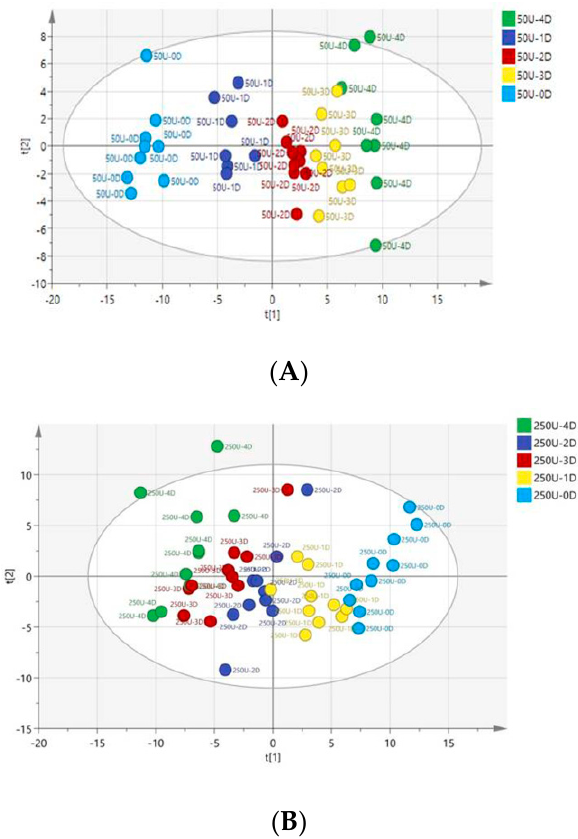
Figure 5. Score plot of OPLS-DA obtained based on the urine samples from the 50-unit group ( A ) and 250-unit group ( B ).